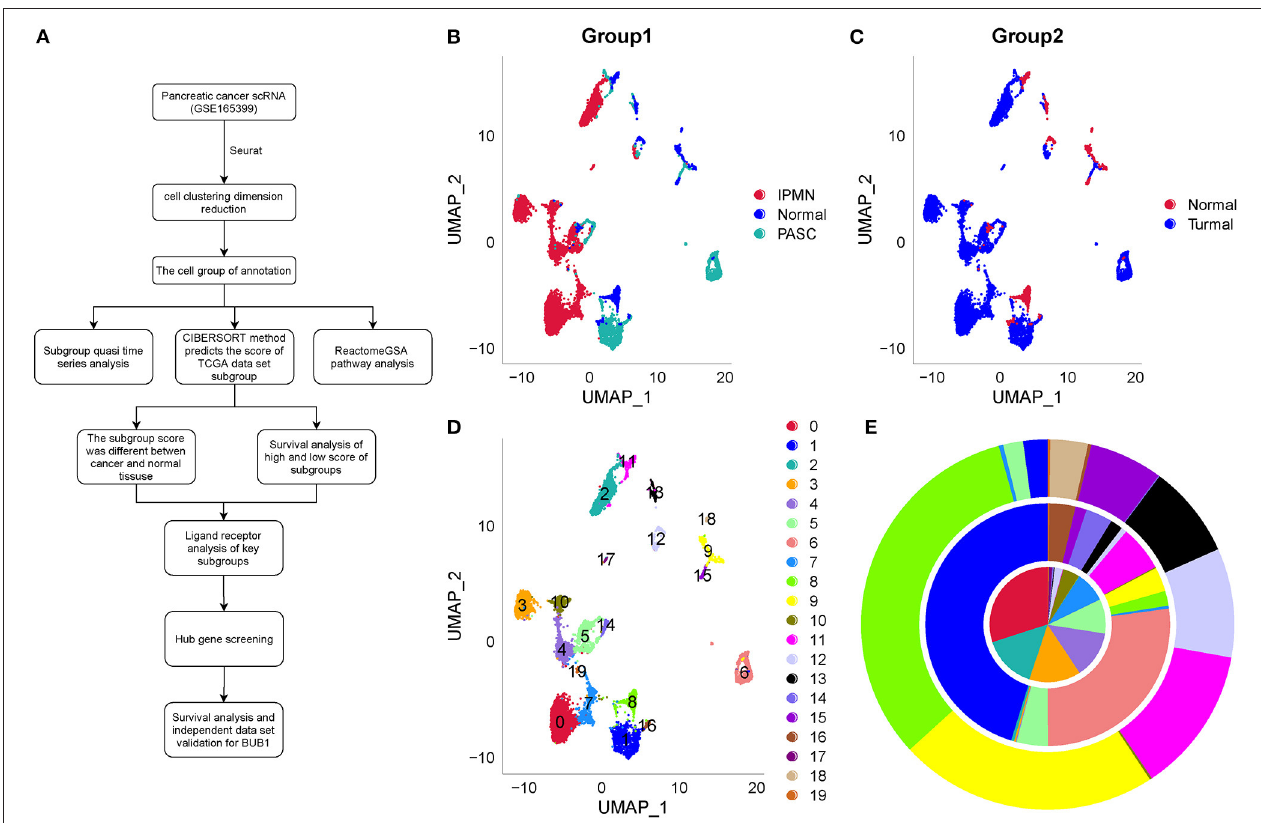
FIGURE 1 | Work flowchart and clustering and dimensionality reduction of one normal sample and two tumor samples by UMAP. (A) Work flowchart. (B) The distribution of three samples labeled by three colors after dimensionality reduction. (C) The distribution of one normal sample and tumor samples. (D) 20 subgroups from C0 to C19 of three samples. (E) The proportion of different subgroups in each sample. IPMN, PASC, and the normal sample located from inside to outside, respectively. IPMN, intraductal papillary mucinous neoplasm; PASC, pancreatic adenosquamous